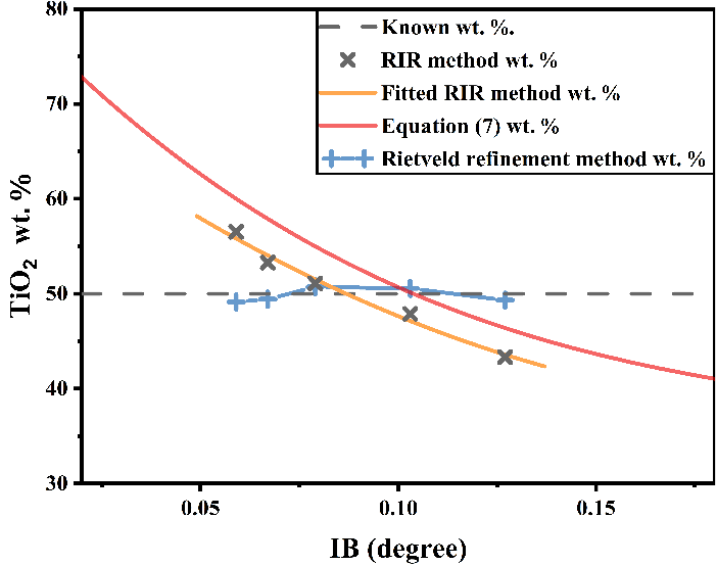
Figure 7. Nano-TiO 2 quantitative curve based on Equation (7), which are compared to known wt.%, experimental wt.% and Rietveld refinement wt.%.